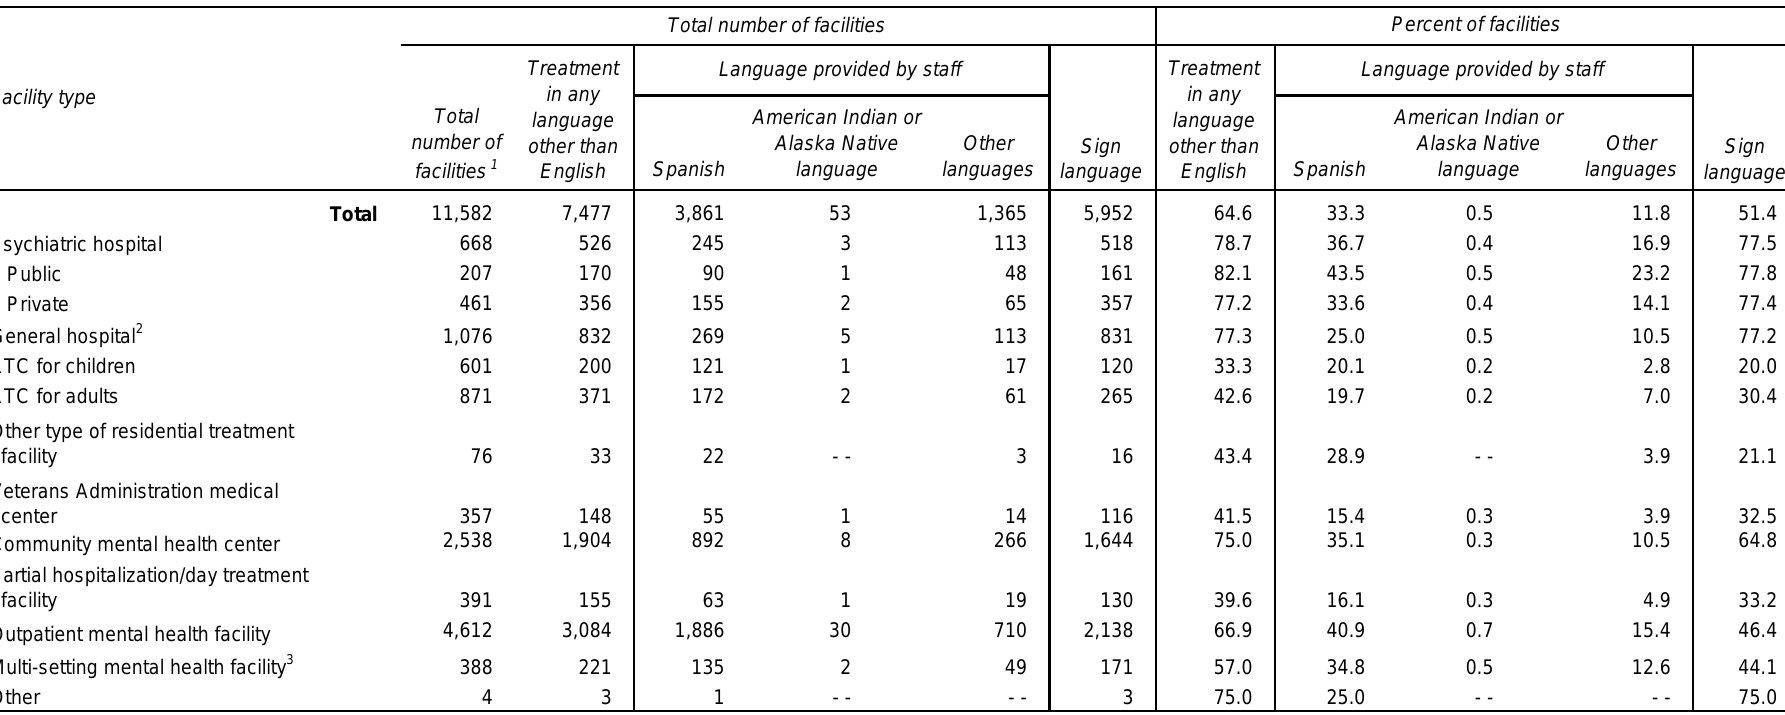
Table 2.7. Mental health treatment facilities offering services in a language other than English and in sign language for the deaf and hard-of-hearing, by facility